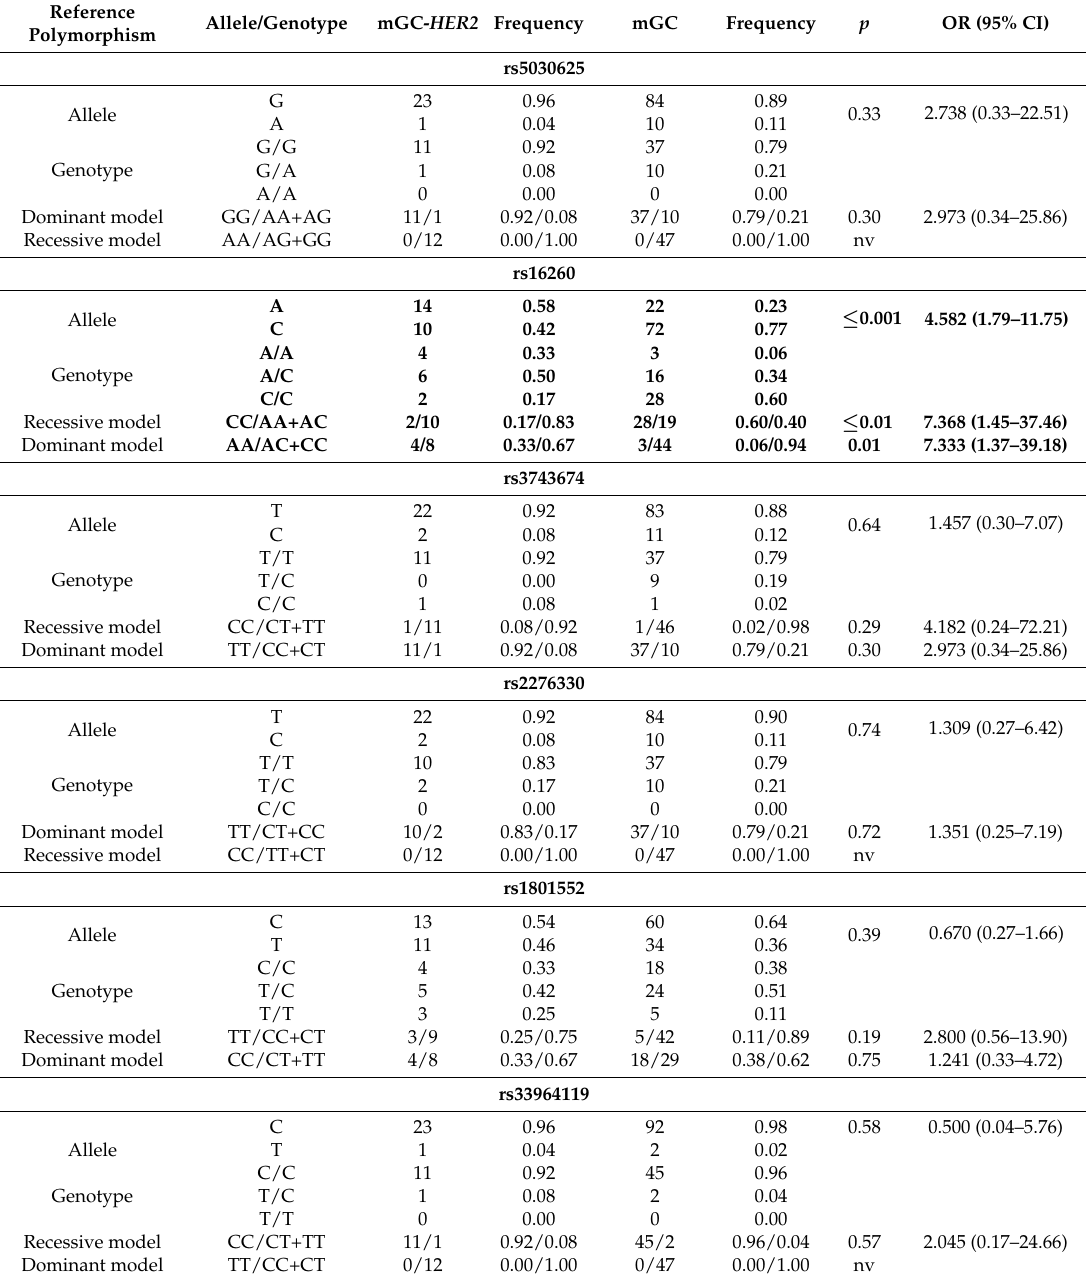
Table 2. Allele and genotype frequencies of CDH1 polymorphic sites in patients with mGC according to the HER2